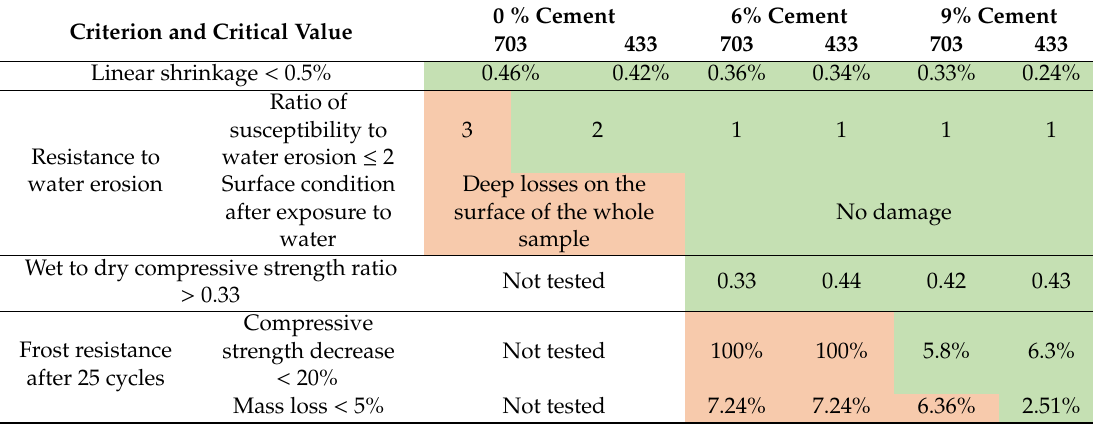
Table 9. Summary of research results. Green color is used to indicate mixtures that meet the criteria for a given characteristic of durability in temperate